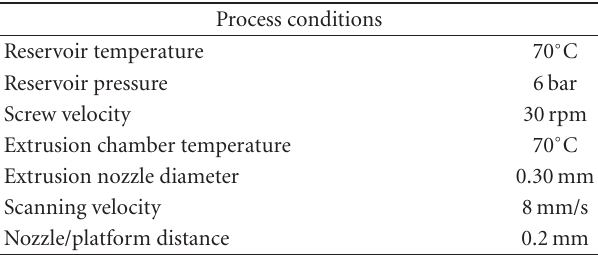
Table 1: Process conditions.